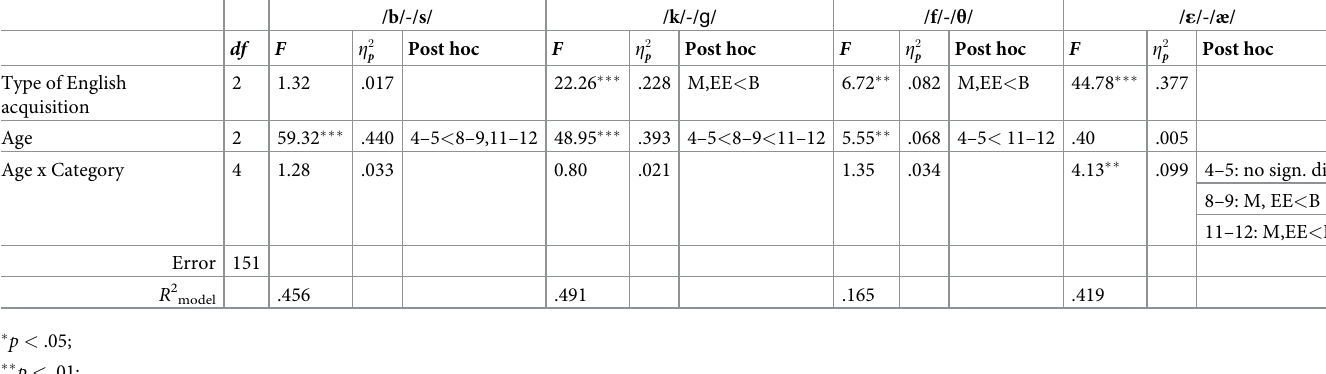
Table 4. ANOVAs with type of English acquisition and age as fixed factors and d’ for each contrast as dependent variable.